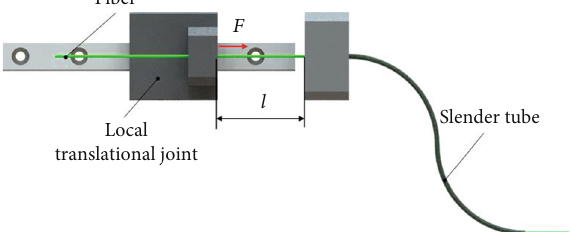
Figure 8: Design of the local translational joint for fi ber insertion. Table 1: Values of parameters and variables in Equation (7). E